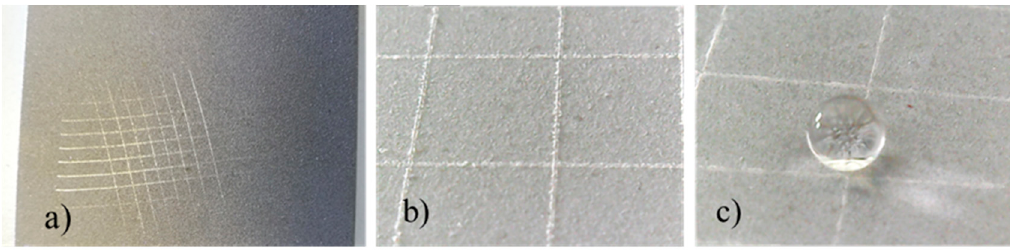
Figure 17 . Cutting and tape test results on coated sample 7, ( a ) surface cut, ( b ) surface magnification, ( c ) surface wettability after test.